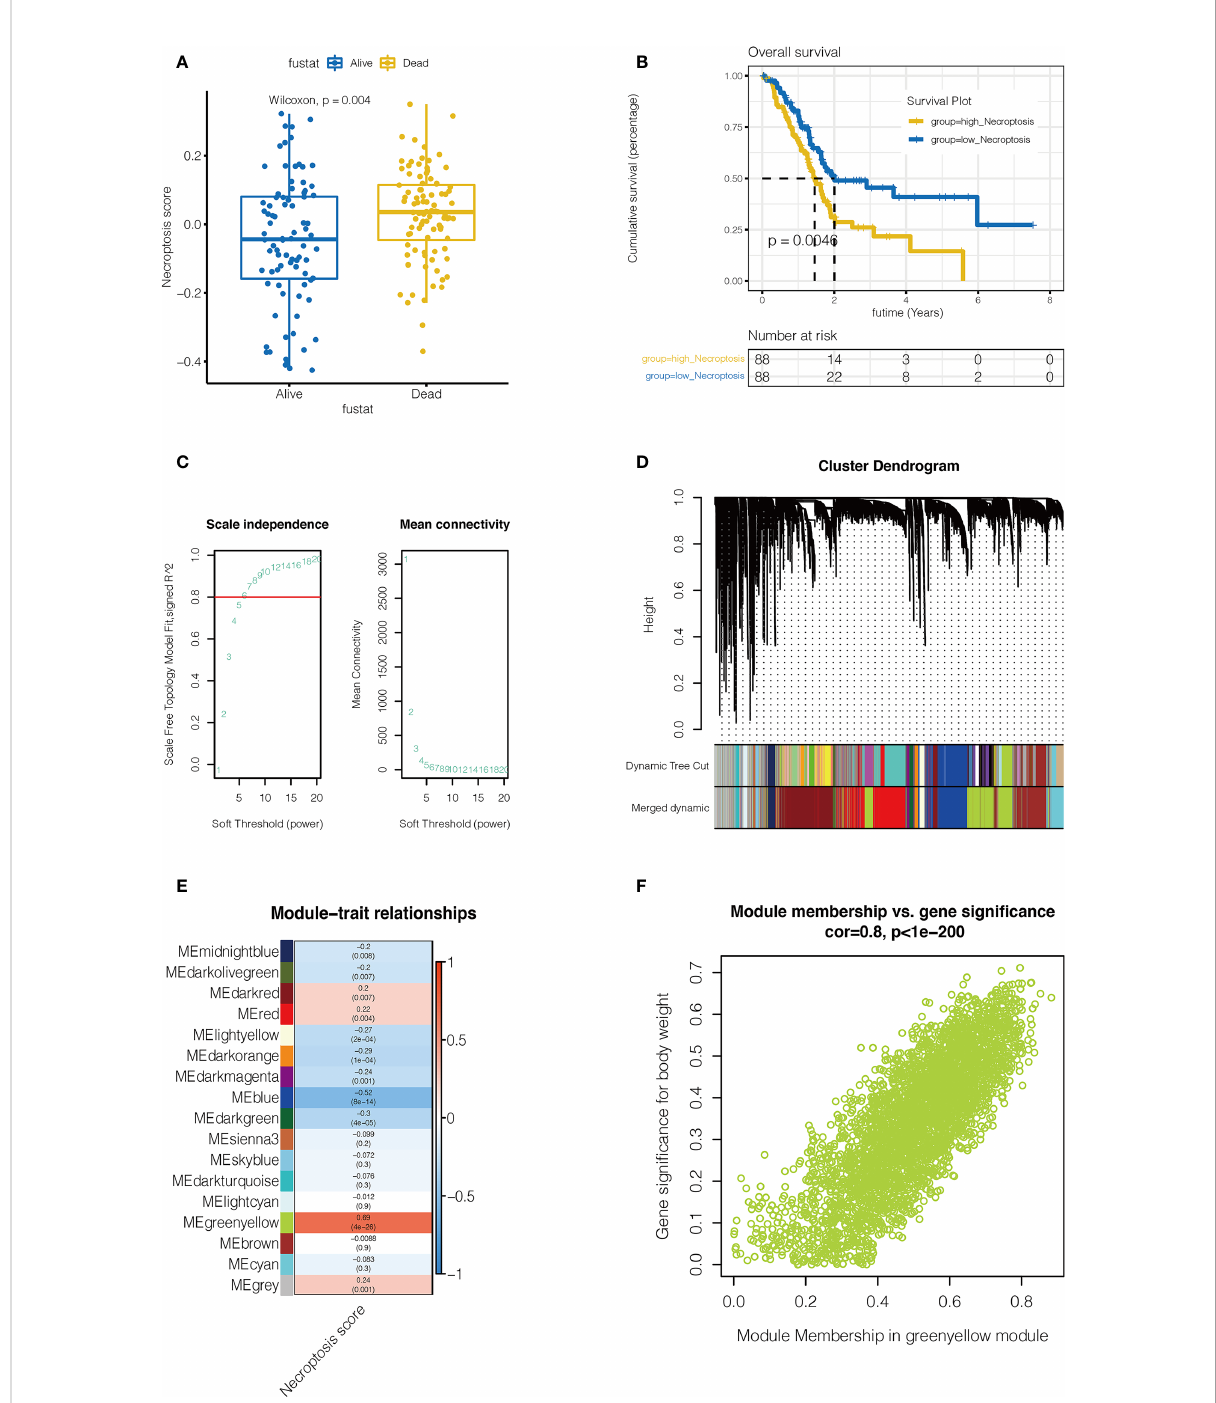
FIGURE 2 Single sample gene set enrichment analysis(ssGSEA) and Weighted Gene Co-expression Network Analysis (WGCNA). (A, B) ssGSEA. The Necroptosis score for each pancreatic cancer patient in the TCGA database was calculated. Necroptosis scores were higher in pancreatic cancer patients who died (P=0.004). Pancreatic cancer patients in the high-necroptosis group had worse outcomes (P=0.0046). (C) WGCNA. When the soft domain value is 7, R^2>0.8, the data is more consistent with the power-law distribution, and mean connectivity tends to be stable, which is suitable for subsequent analysis. (D) First the minimum number of modules is set to 100, deepSplit is 3, and a total of 27 non-grey modules are obtained. Then, the similarity domain value of modules was set to 0.4, and the modules lower than this value were combined to obtain 16 non-gray modules. (E) MEgreenyellow module was most closely associated with necroptosis, containing 3352 genes (COR = 0.8, P <0.001). (F) The correlation between gene signi fi cance for body weight and module membership (COR = 0.8, P